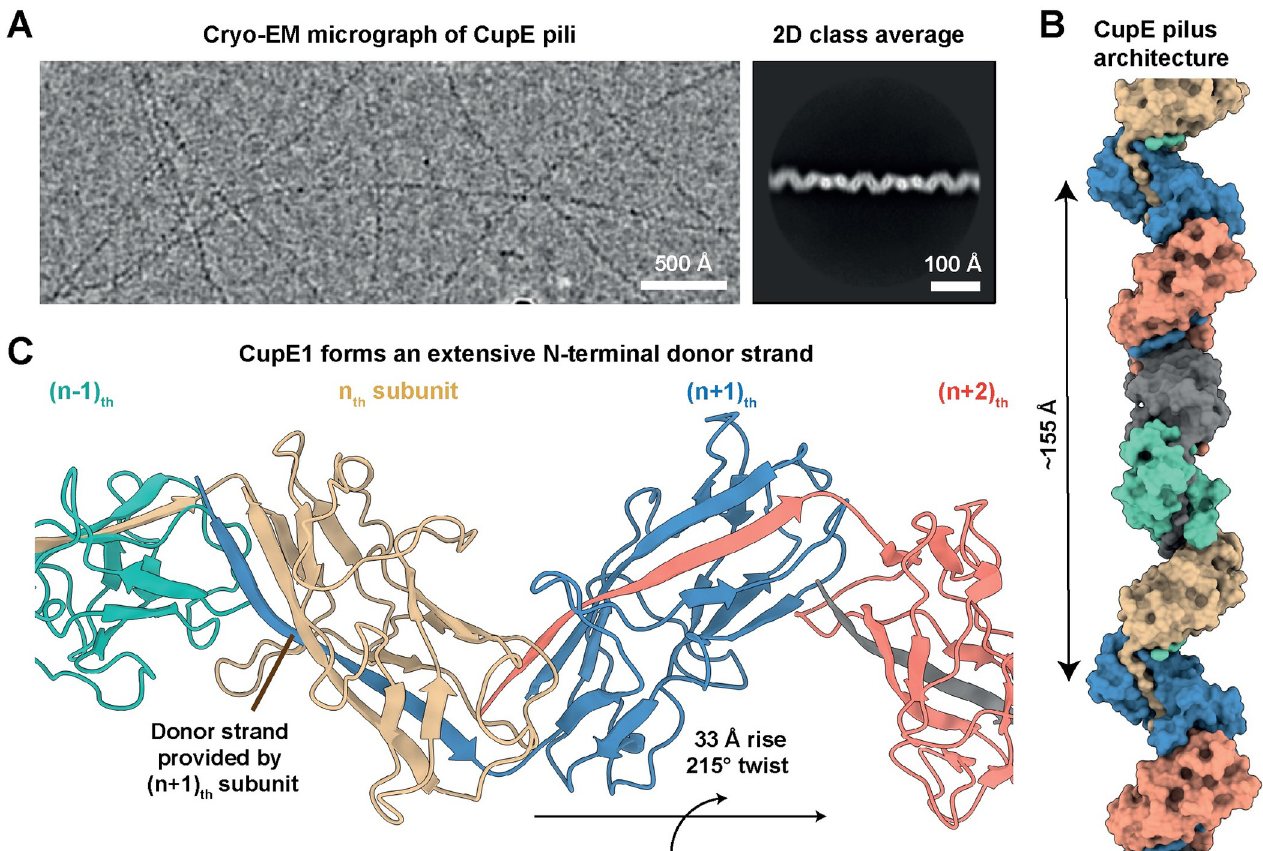
Fig 1. CupE1 subunits within the CupE pilus are arranged in a zigzag architecture. (A) Raw micrograph and 2D class average of CupE pili show zigzag- shaped filaments. (B-C) A 3.5 Å resolution cryo-EM structure of the CupE pilus reveals how CupE1 subunits are arranged in a zigzag pattern, with the donor strand of the (n+1) th subunit enveloped by the incomplete Ig-like fold of each n th subunit. Five CupE1 subunits form a longer repeat of ~155 Å